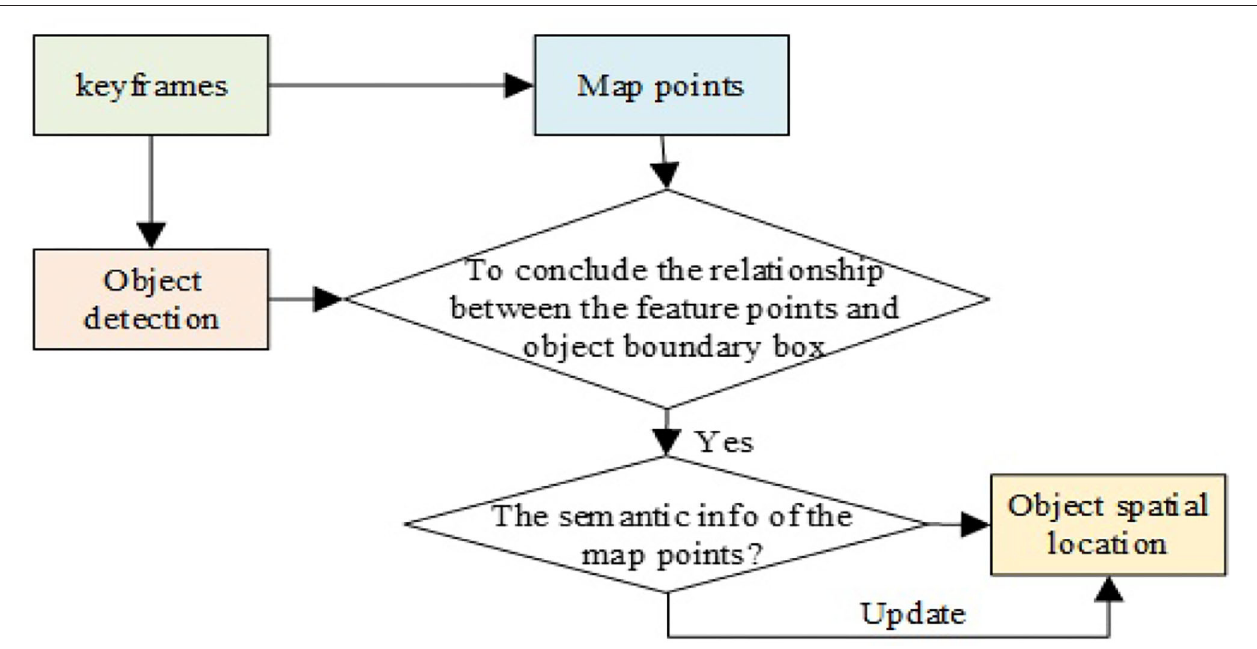
FIGURE 6 | The procedure of the spatial target position